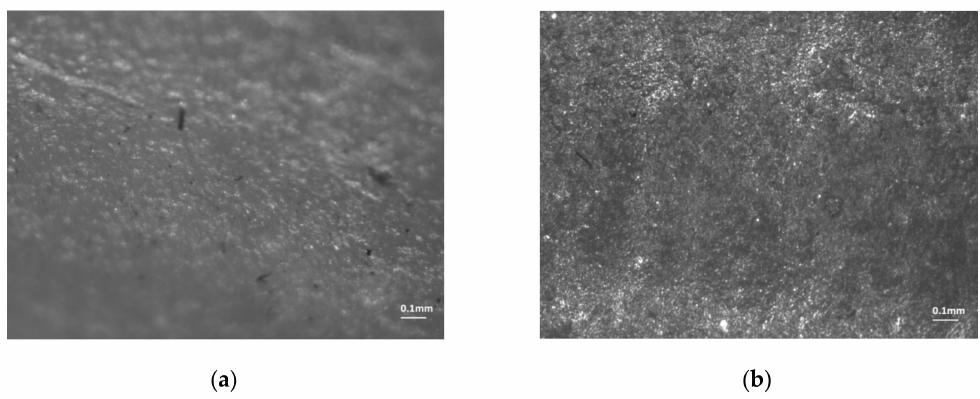
Figure 19. Microscopic views (1:1 × 10 − 4 m scale) of the lateral surface of the artifact in the glossy finish area located: ( a ) parallel to the X-axis (0 ◦ ); ( b ) parallel to the Y-axis (90 ◦ ).